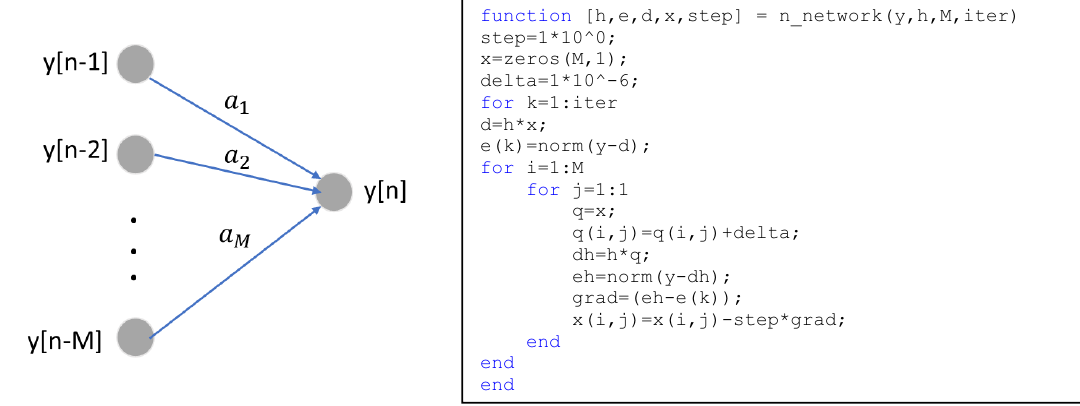
Fig. 1 Neural network model of an LDE and the associated MATLAB function for the solution of its